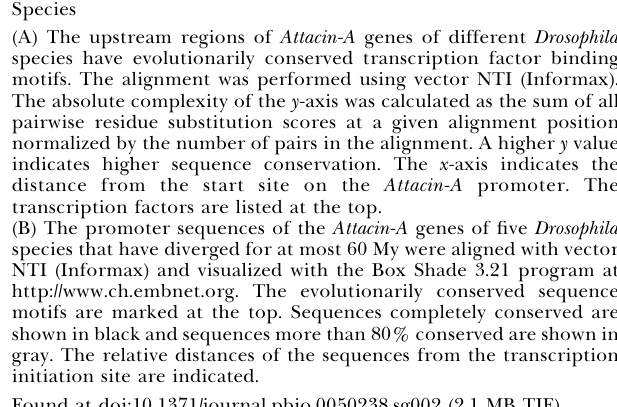
Figure S4. Putative Binding Sites of the Promoter Regions of AMP Genes